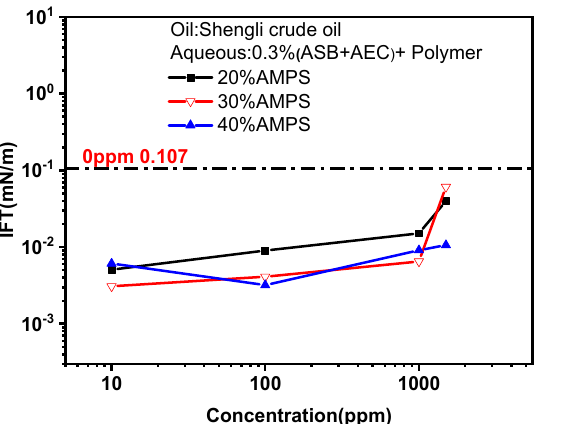
Figure 7. Effect of polymer concentration on equilibrium IFTs between 0.3 wt% ASB@AEC solution and Shengli crude oil.